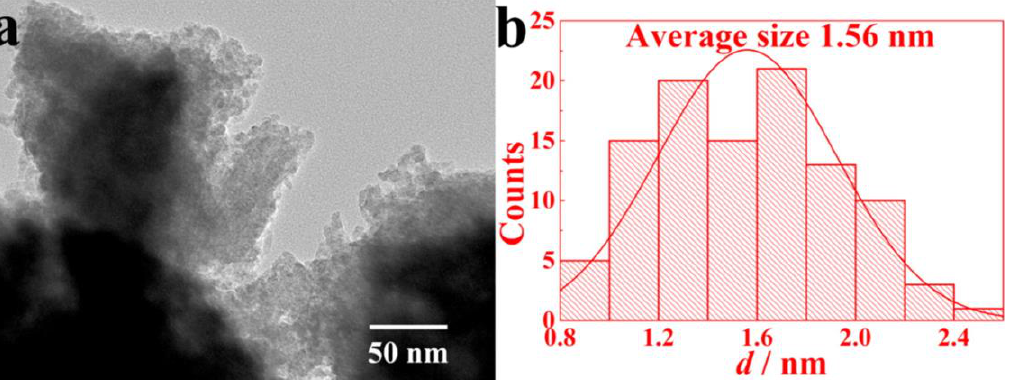
Figure 9. Fe-Cr alloy synthesized at the concentration ratio c Fe(II) /c Cr(III) of 1:2 in ChCl-EG DES. ( a ) TEM image; ( b ) The particle size histogram. T = 333 K; U = 2.8 V. Reproduced from [18] with permission from Elsevier, 2022.